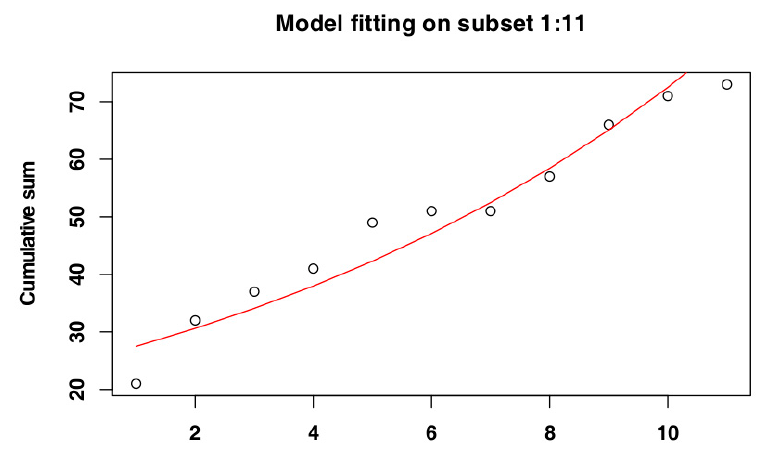
Figure 8. Model fitting for the selected subset for Belgium data.